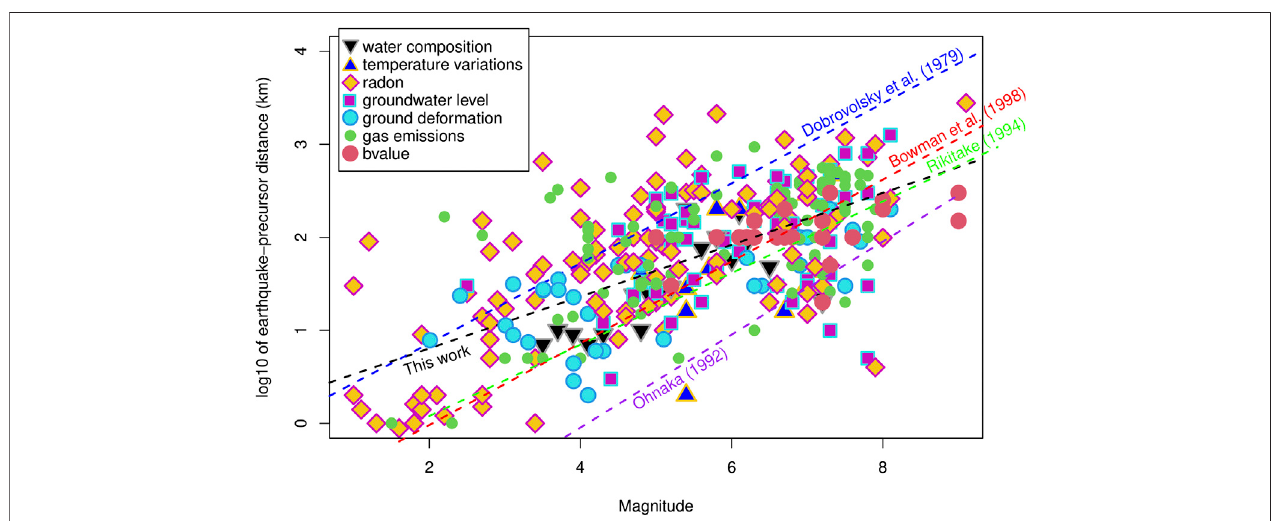
FIGURE 2 | Scatter plot of magnitude vs logarithm of the earthquake-precursor distance for all the seismic precursors cataloged in this work. The blue, green and gray lines aretheearthquake-precursordistancevsmagnitude relation suggestedbyDobrovolskyet al.(1979),Rikitake(1994) andOhnaka(1992) respectively.Thered line is the critical region radius (radius of the earthquake preparation area) vs magnitude proposed by Bowman et al. (1998). The black line is the empirical best fi t of the data cataloged in this work.